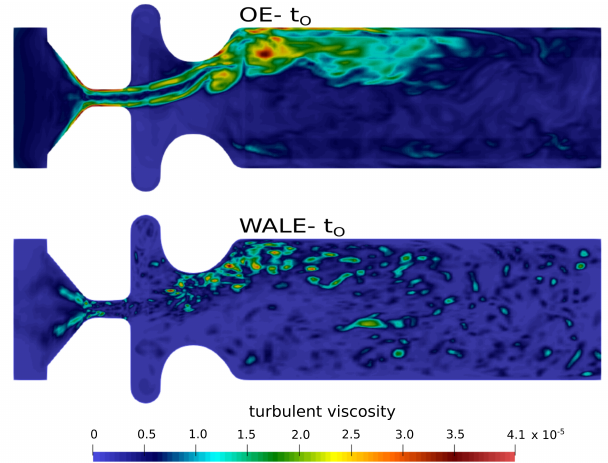
Figure 6. Turbulent viscosity ν t [m 2 s − 1 ] in mid–coronal